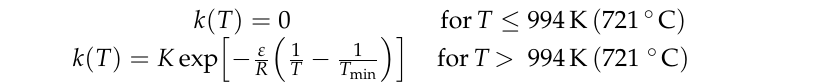
regression parameters T min = 836.8 ◦ C, K = 0.07198 s − 1 , ε = 279.1 kJ/mol, ε s = 175.2 kJ/mol, and a = 0.1658 K − 1 , the family of predictive curves was drawn, see Figure 7, where the problem with temperatures close above 721 ◦ C